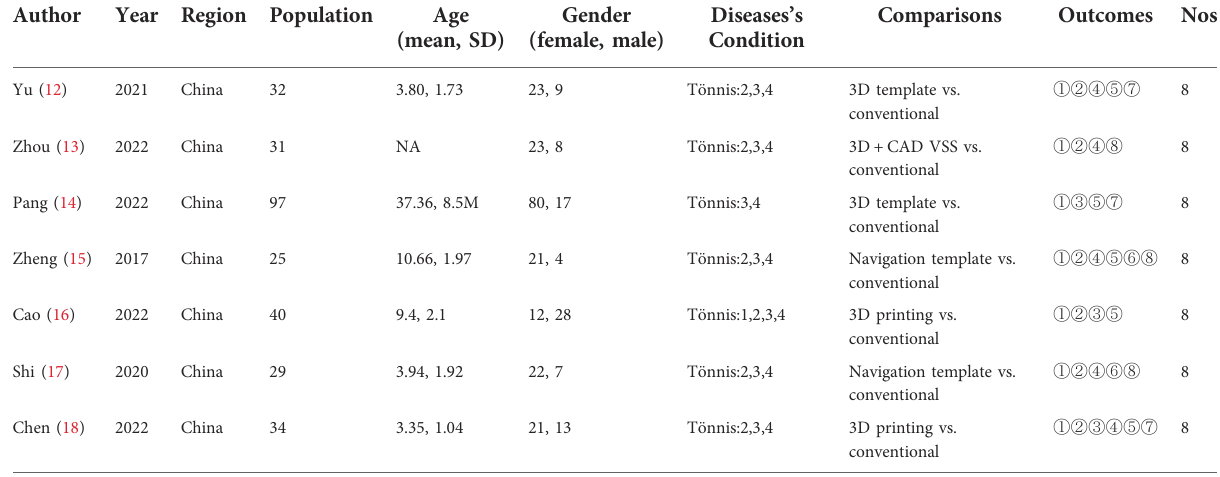
TABLE 1 Characteristics of the included studies.